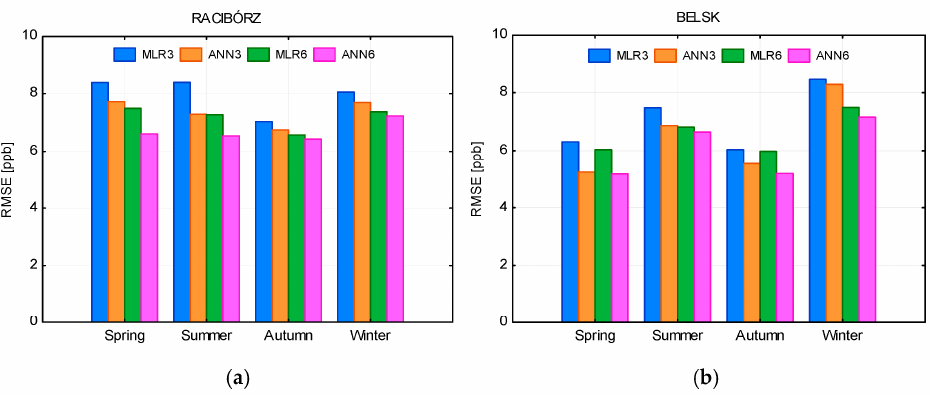
Figure 11. The same as Figure 8 but for root mean square error (RMSE) for Racibórz ( a ) and Belsk